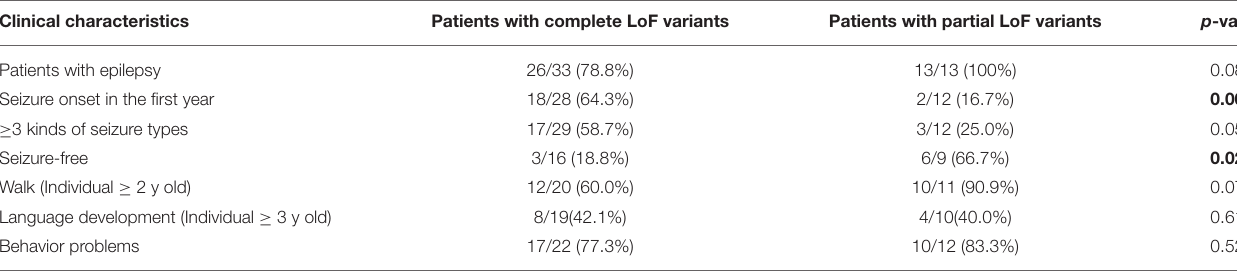
TABLE 2 | Comparisons of patients with partial and complete LoF KCNB1 variants in clinical